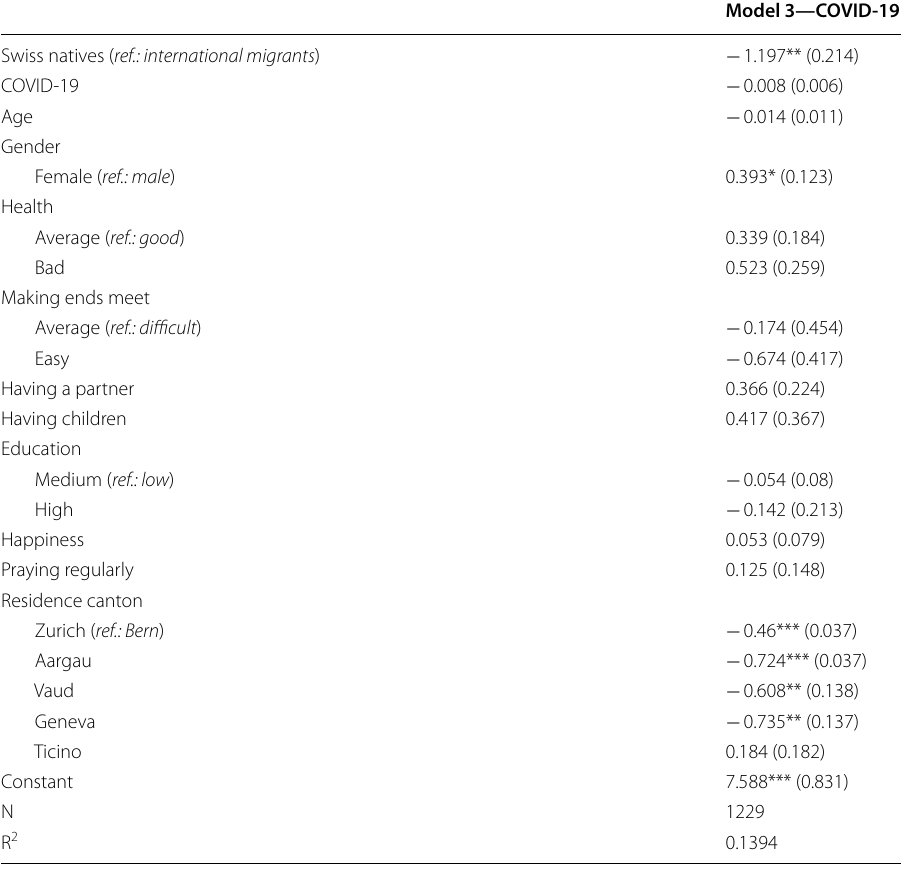
Table 4 Linear regression to test COVID‑19 indicator on worry about the